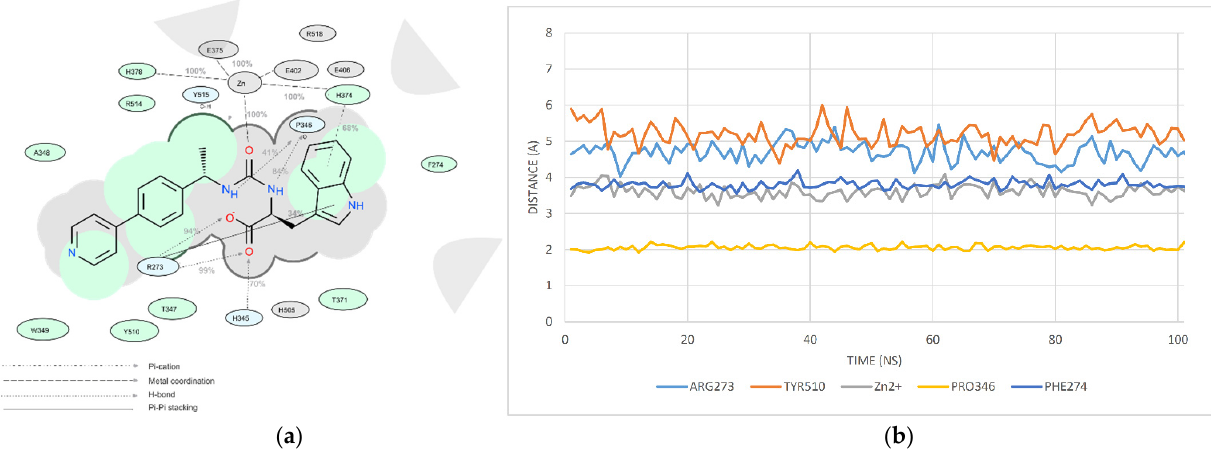
Figure 14. A detailed interaction scheme of ligand atoms (Z3969355209) with protein residues (100 ns): ( a ) generalized graphical representation of the interactions and contacts (H-bonds, hydrophobic, ionic, water bridges); ( b ) scheme showing the distance evolution (in Å) between the ligand and residues.